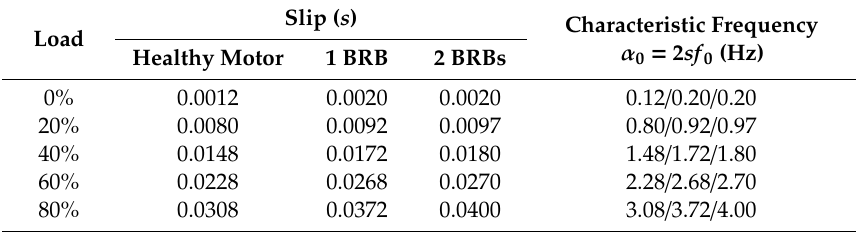
Table 5. The slips and characteristic frequencies of three fault cases under di ff erent